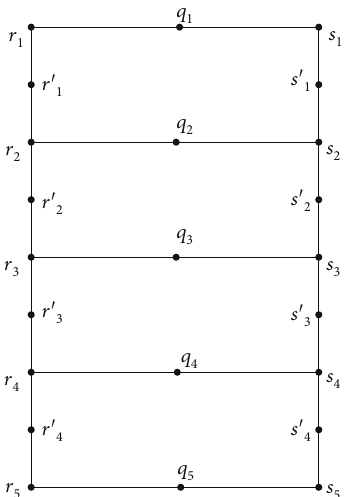
Figure 9: S ð L Þ is a C -exponential mean 5